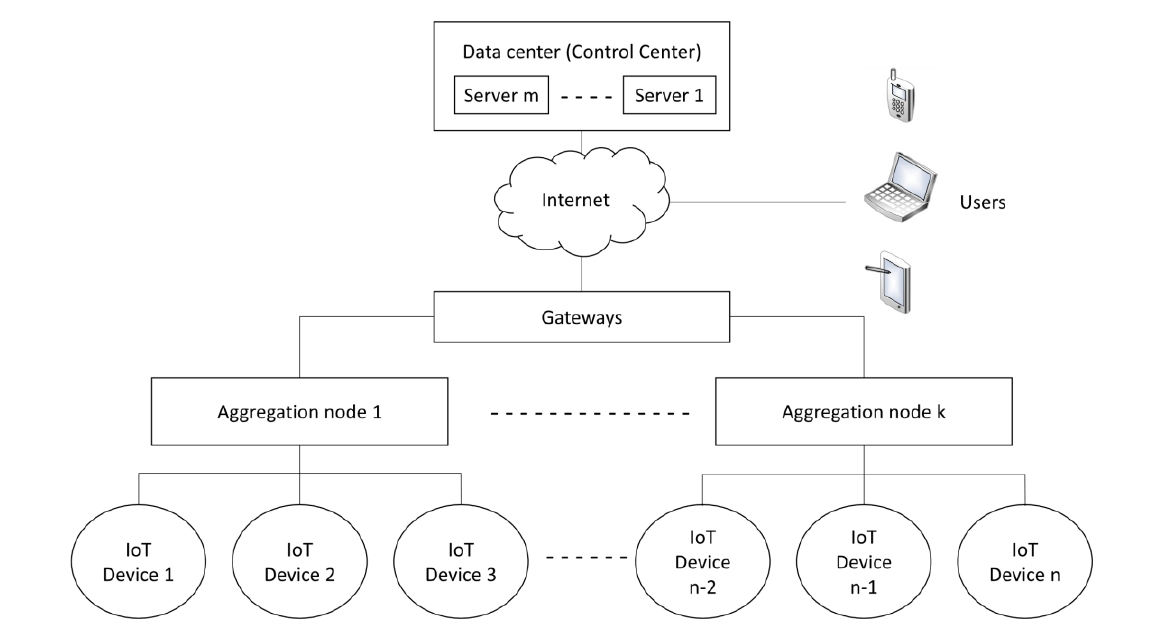
Figure 30. An example of an Internet-of-Things system with “n” IoT devices, “k” aggregation nodes, and “m” servers [114]. Abbreviations used: IoT, Internet of Things. Reprinted with permission from ref. [114]. 2020 Elsevier.